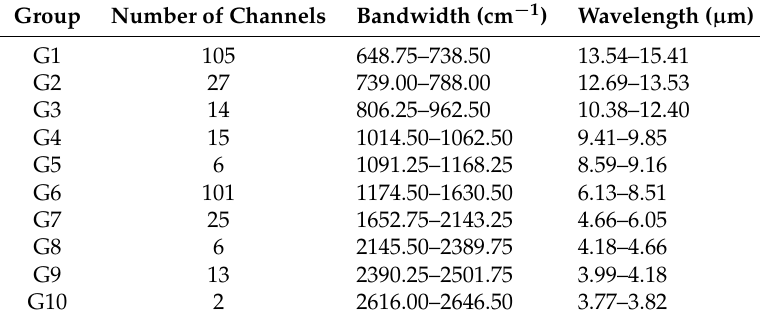
Table A2. The number of IASI channels per averaging